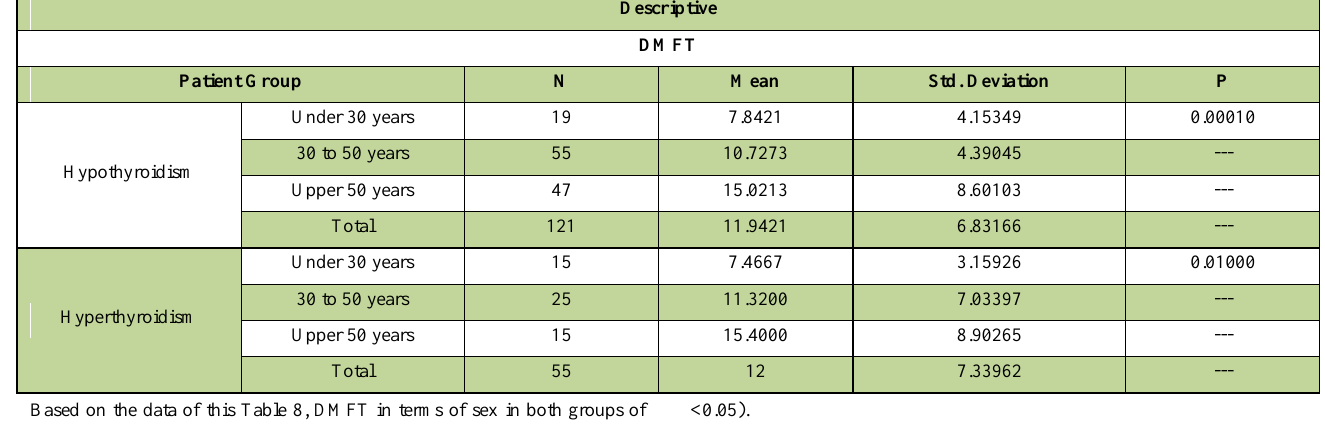
Table 7. Mean and standard deviation of DMFT in 2 patient groups by age.